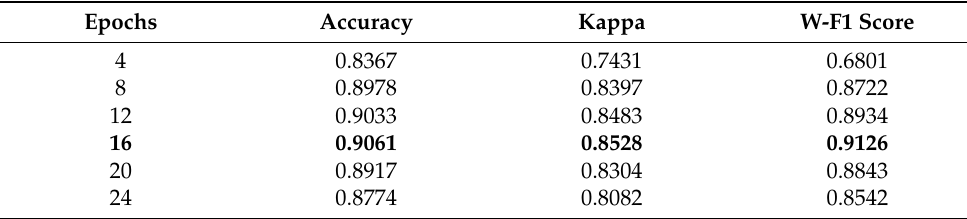
Figure 7. Selection of epochs. Table 3. Selection of epochs.